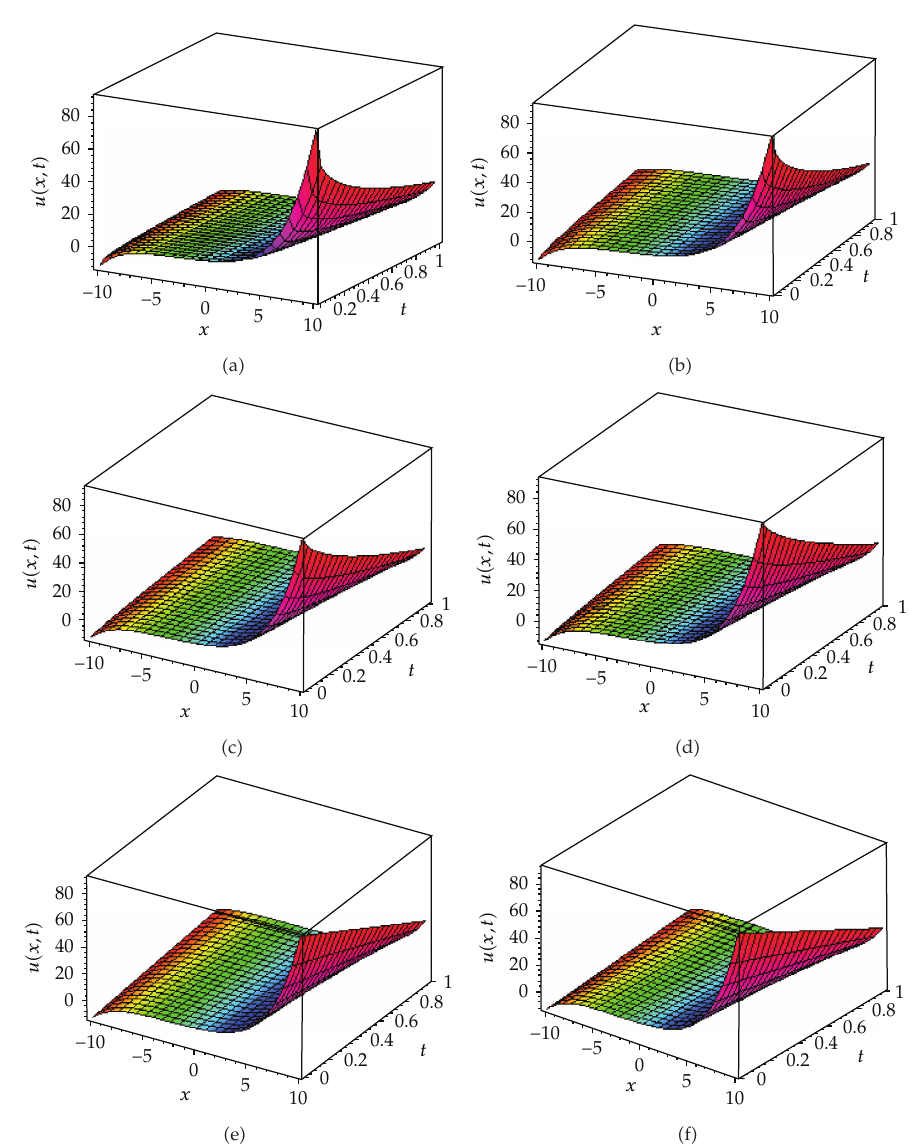
Figure 1: The surface shows the solution u (cid:3) x,t (cid:4) for (cid:3) 1.1 (cid:4) : (cid:3) a (cid:4) α (cid:8) 1 / 3, (cid:3) b (cid:4) α (cid:8) 1 / 2, (cid:3) c (cid:4) α (cid:8) 2 / 3, (cid:3) d (cid:4) α (cid:8) 3 / 4, (cid:3) e (cid:4) α (cid:8) 1, and (cid:3) f (cid:4) exact